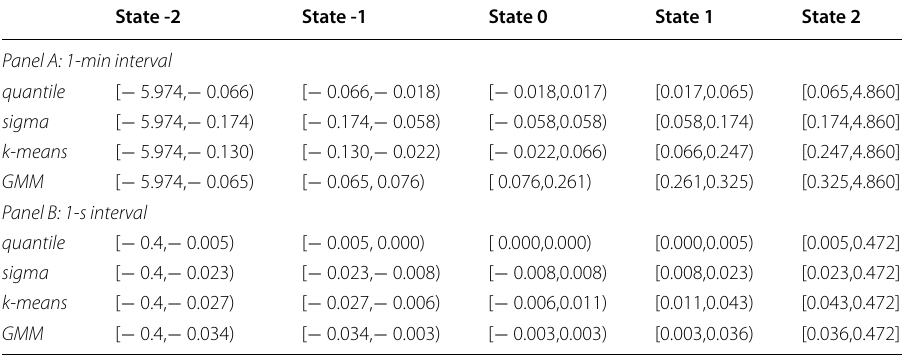
Table 3 Extreme values of the states bins for the four discretization approaches with 5 states applied to the Bitcoin